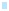
Functional categorization of differentially expressed genes during tomato fruit development in Ailsa Craig.The differences between 14 and 7 DAF are indicated by light green squares (∎). The differences between 21 and 7 DAF are indicated by green squares (∎). The differences between 28 and 7 DAF are indicated by dark green squares (∎), The differences between 35 and 7 DAF are indicated by yellow squares (∎), The differences between 42 and 7 DAF are indicated by orange squares (∎), The differences between 49 and 7 DAF are indicated by red squares (∎). Percentages are calculated based on the proportion of the number of genes in each set.